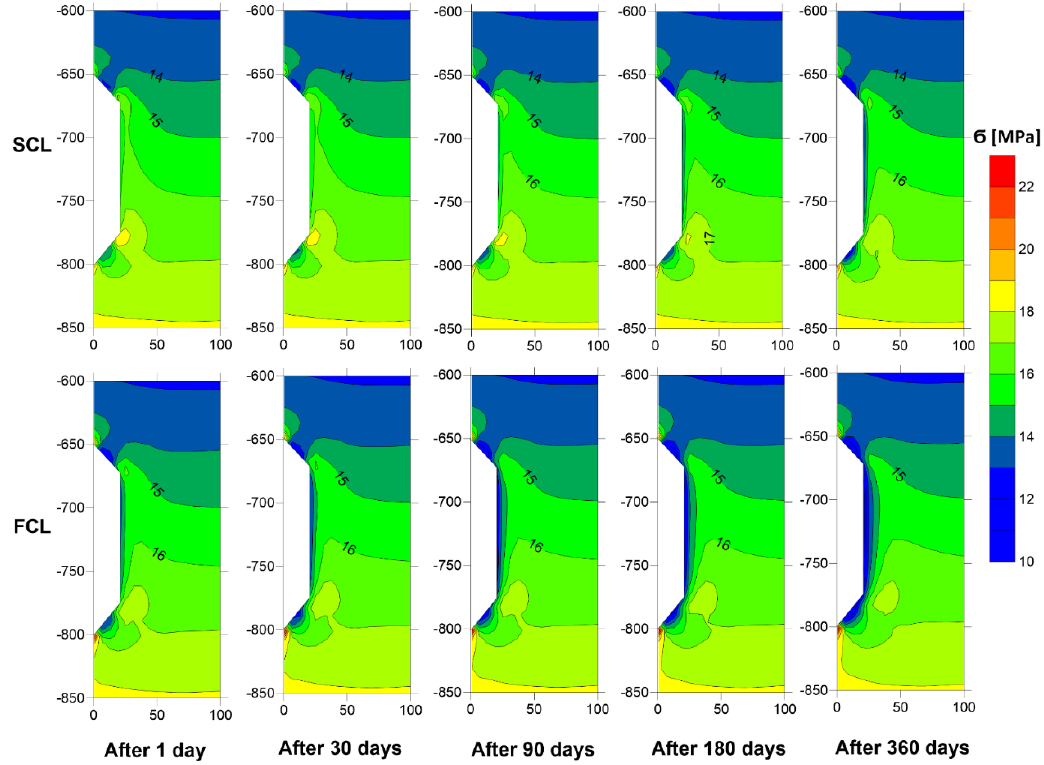
Figure 6. Comparison of stress distributions in the rock mass at the end of 1, 30, 90, 180 and 365 days of CAES cavern operation for models with slow-(SCL) and fast-creep law (FCL), with temperature changes in the rock mass. When comparing both the models used in the simulations (Figure 7), it was noticed that the applied creep law affects the values obtained up to a distance of 50 m from the cavern axis, regardless of the considered cavern point in a given case (ceiling, side wall, bottom). This translates into the real range of cavern impact differences, depending on the type of salt (fast-creeping or slow-creeping) up to a maximum of 23–24 m from the cavern wall (the considered model has a radius of 17.84 m). It should be noted that in slow-creep- ing salts the intermediate stresses in the rock mass in the immediate vicinity of the cavern are about 3 MPa higher than in fast-creeping salts.